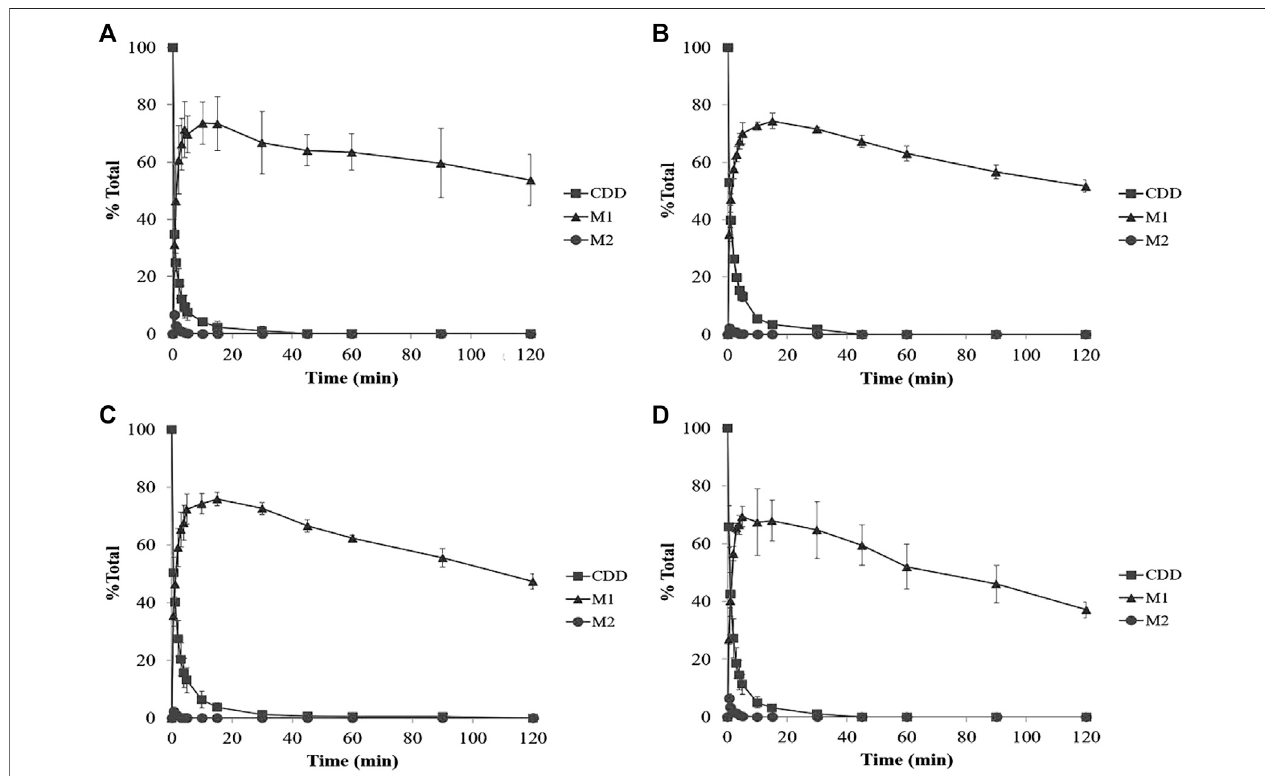
FIGURE4 | Percent CDD and its metabolite timepro fi les in (A) HLS9, (B) MLS9, (C) DLS9, and (D) RLS9 as afunction of incubation time. The mixtures containing CDD (3 µM) and HLS9, MLS9, DLS9, and RLS9 (1 mg/ml) were incubated at 37 ° C.